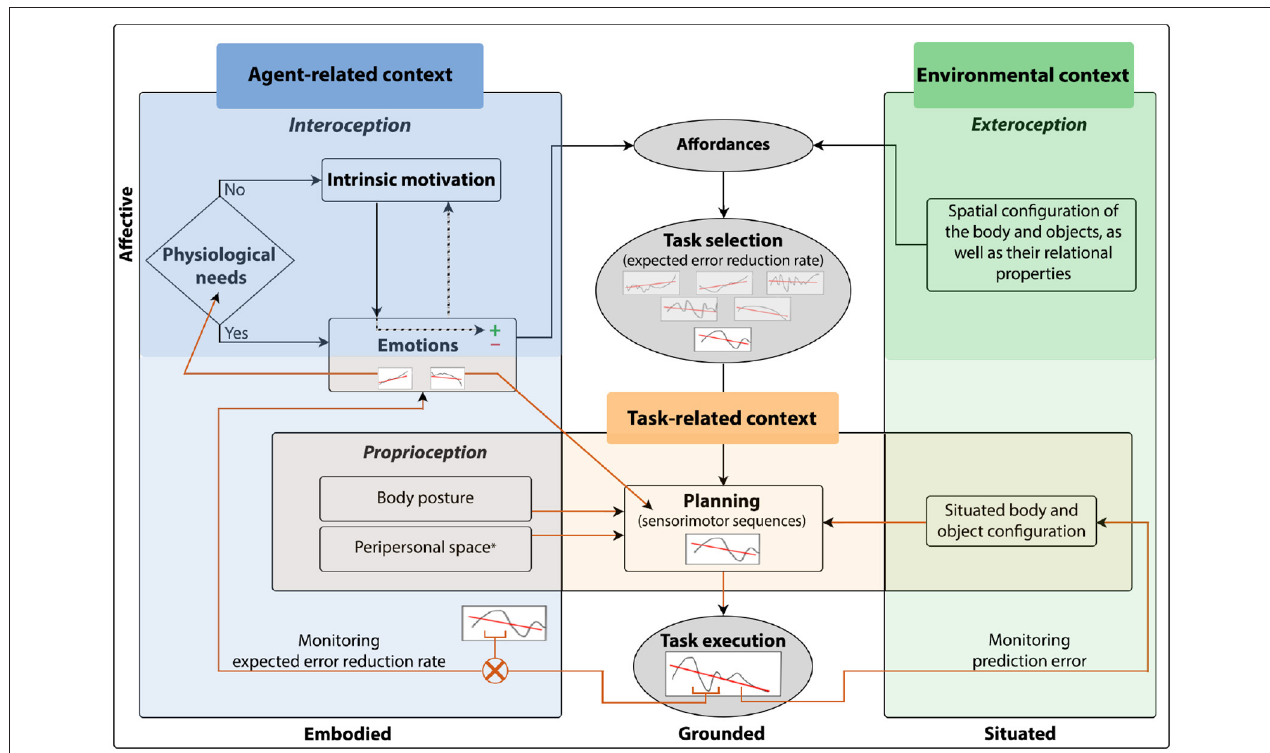
FIGURE 2 | Interactionist model of contexts. Schematic representation of the three different types of context and the interaction of their core elements for selection, planning, execution, and when necessary switching of a